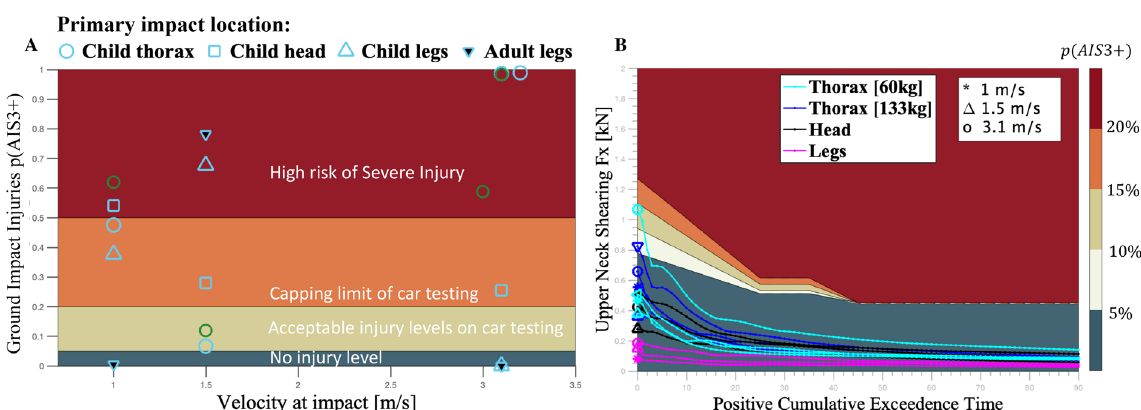
Figure 5. Injury risk probabilities on a fall. ( A ) Head injury criteria measured upon contact with the ground (concrete) as a secondary injury caused by the blunt impact with a robot or personal mobility vehicle. ( B ) Neck shearing forces showed an over 5% risk of serious injury for impacts on the thoracic